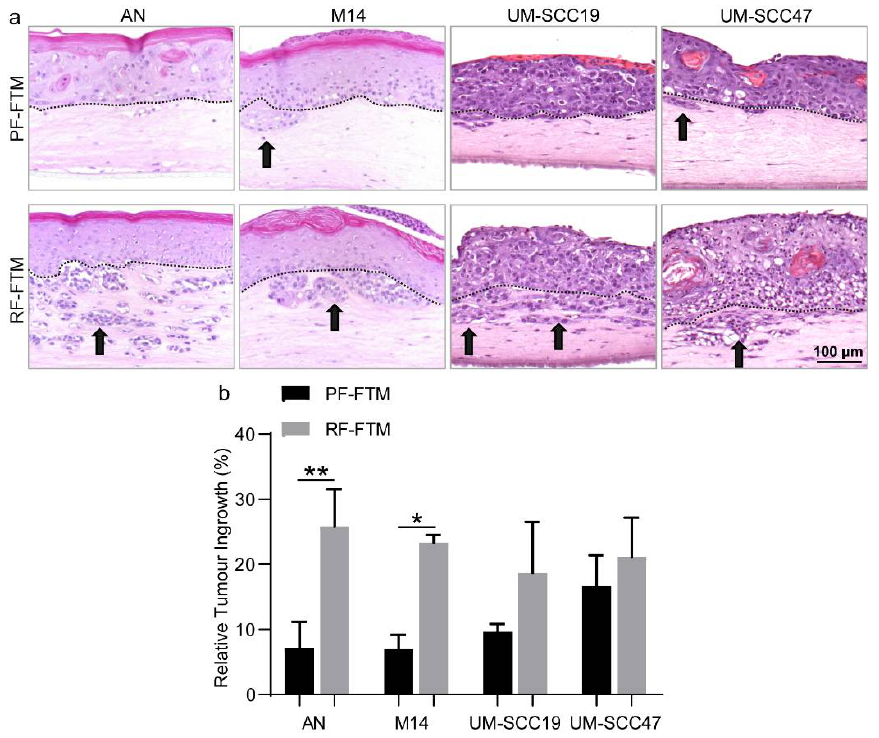
Figure 2. Effects of fibroblast subpopulations on melanoma and HNSCC invasion. ( a ) HE staining of PF-FTMs and RF-FTMs with different epidermis generated using AN, M14, UM-SCC19 or UM- SCC47 cell lines. Arrows indicate the invaded tumor area; dashed lines indicate the basement membrane separating epidermis and dermis. By using Image J, ( b ) quantification of the relative tumor ingrowth in AN, M14, UM-SCC19 and UM-SCC47-FTMs. Data was collected from three independent experiments and is presented as mean ± standard deviation (SD); * p < 0.05, ** p < 0.01.